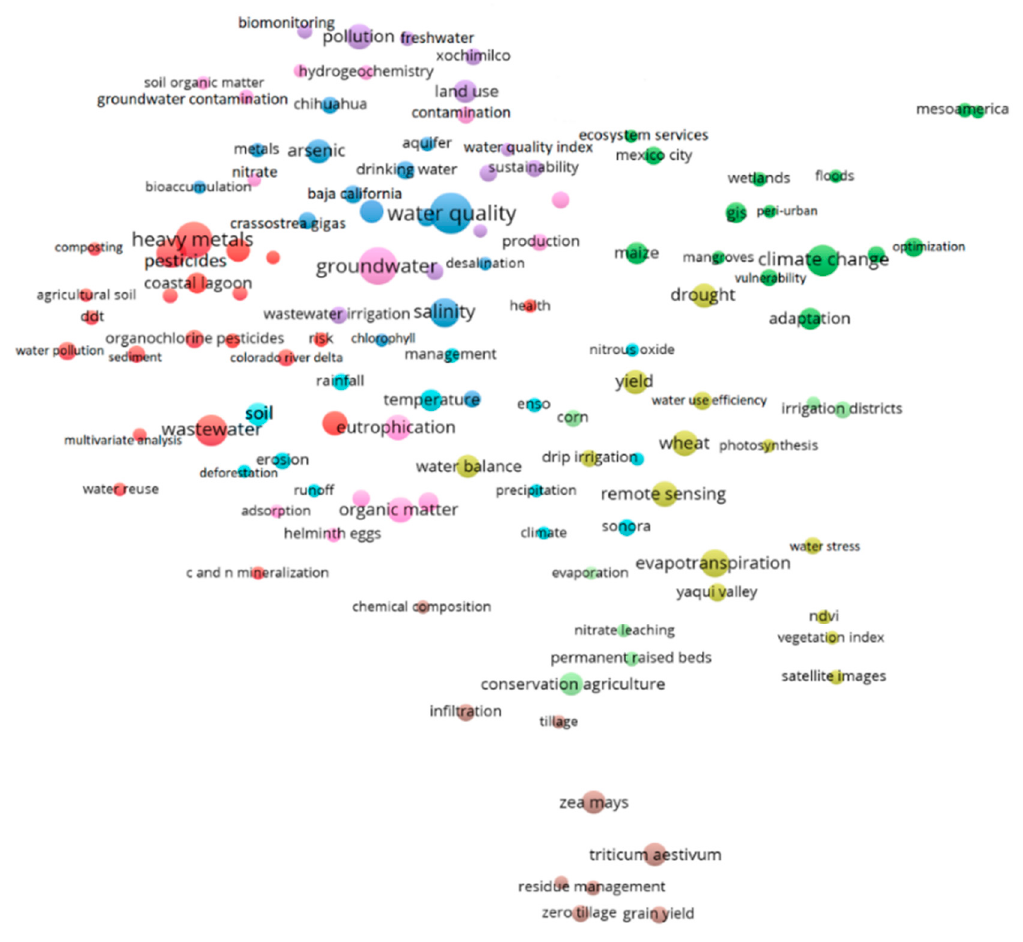
Figure 2. Trends in main keywords related to agricultural water management in Mexico (AWMM) Trends in main keywords related to agricultural water management in Mexico research. (AWMM)